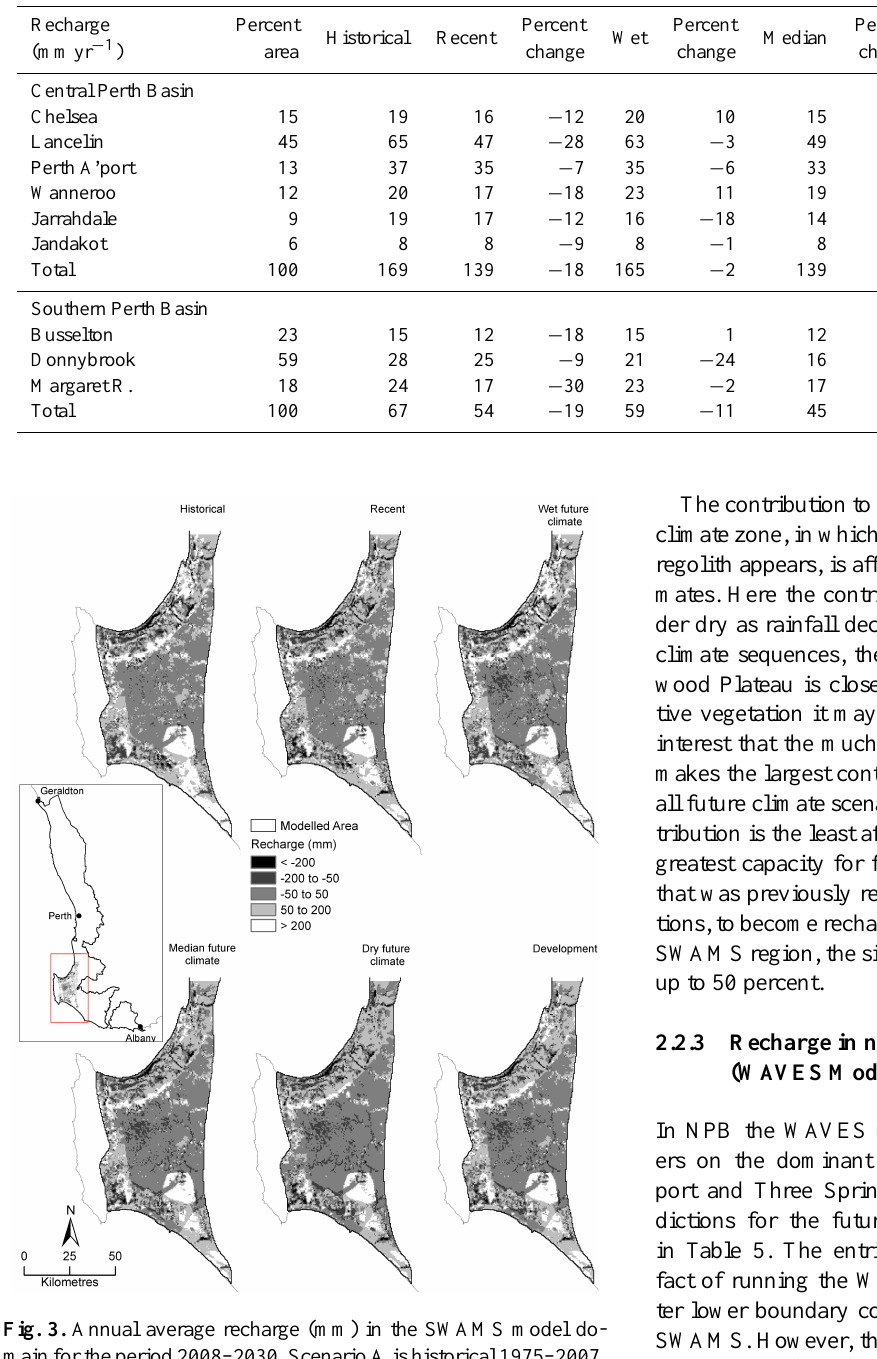
Table 4. Average recharge (mmyr − 1 ) simulated with linked MODFLOW models. Contribution and total recharge shown for each PRAMS and SWAMS climate zone using current and future climates, and percentage departure from modelled values of historical record. Recharge value is rounded off for presentation purposes.